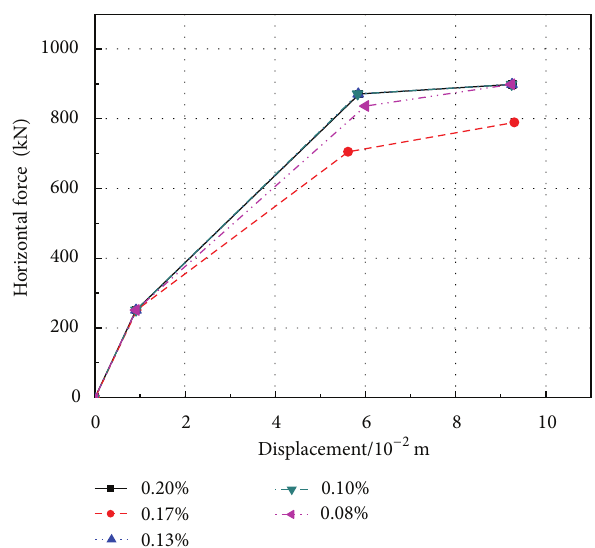
Figure 7: Key points on the skeleton curve of bottom section of PRC pier with different longitudinal reinforcement ratios.